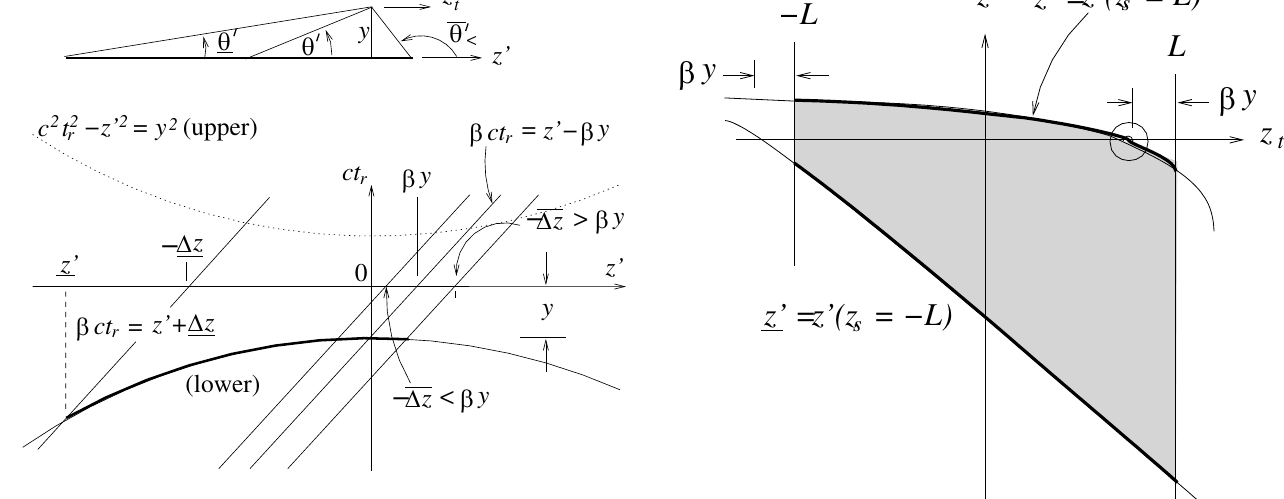
FIG. 3. Figure illustrating the y (cid:1) 0 retarded time calcula- tion. The upper figure shows the effective electrostatic configu- ration. In the lower figure the lower hyperbolic branch contains points from which emitted signals arrive at observation point P at t (cid:1) 0 . Straight lines are world lines of point charges in the line charge distribution. Heavy lines in both figures correspond to the effective charge distribution. Depending on y , the head may be longitudinally in front of, or behind, the test